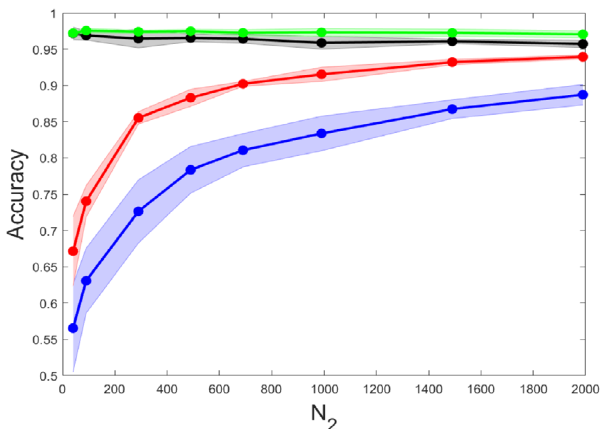
Fig. 7 Deep non-linear scheme. The accuracy of the non-linear deep neural network is tested. We assume a four layers network with, respectively, N = 784, N N = 120, N = 10; N 1 2 , 3 4 2 is changed so as to enlarge the set of parameters to be trained. The red line refers to the spectral training, with N + N + N 2 3 4 adjusted eigenvalues. The blue line stands for a neural network trained in direct space, the target of the optimisation being a subset made of N 2 + N 3 + N 4 weights, randomly selected from the available pool of N 1 N 2 + N 2 N 3 + N 3 N 4 tunable parameters. The black line reports the accuracy of the linear neural network when training the full set of N 1 N 2 + N + N N N 2 3 3 4 weights. The green line refers to the spectral learning when eigenvalues and eigenvectors are simultaneously trained. Table 1 Average performance. MNIST best mean accuracy Linear wide Linear deep Non-linear over the explored range